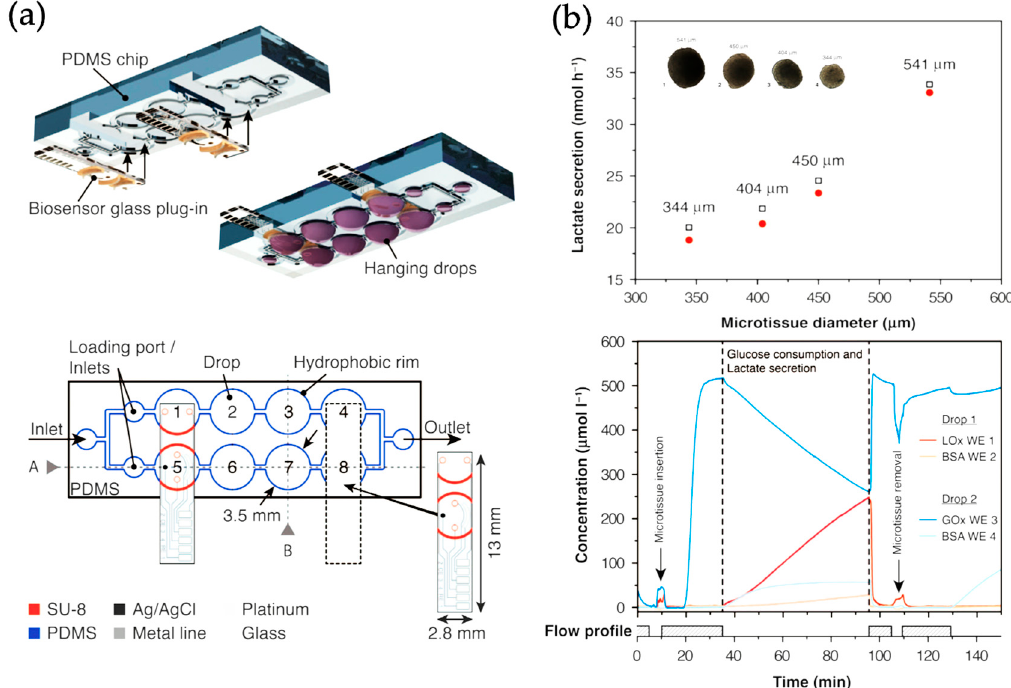
Figure 2. ( a ) Schematic view of hanging-drop chip for cancer organoids with an attached biosensor. ( b ) Measurement of glucose consumption and lactate secretion. (Adapted from [42] with permission from Nature Publishing Group 2019).